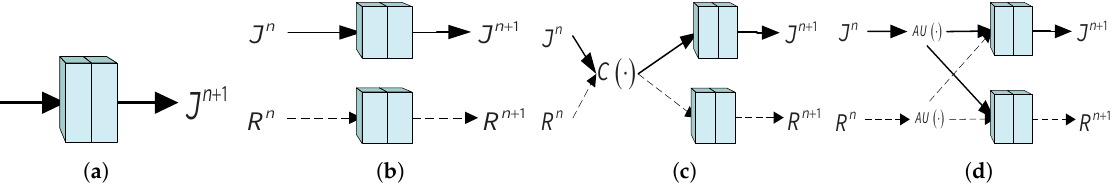
Figure 3. The basic flow of different frameworks. Here, C ( · ) denotes the concatenation operator and AU ( · ) denotes the attention unit. ( a ) Sequential framework. ( b ) Multi-branch framework. ( c ) PCNet [17]. ( d ) Our